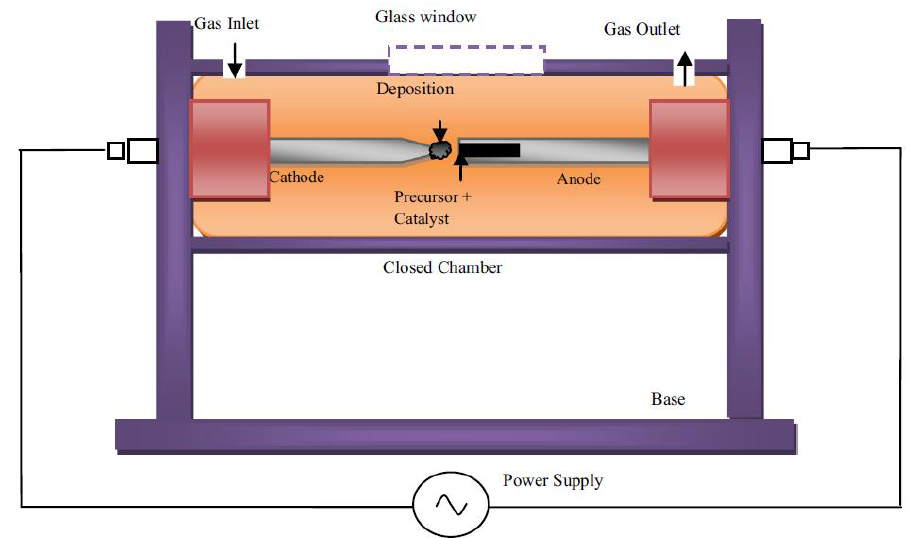
Figure 1. Schematic of arc discharge synthesis of MWCNTs [15]. Reproduced with permission from Elsevier.